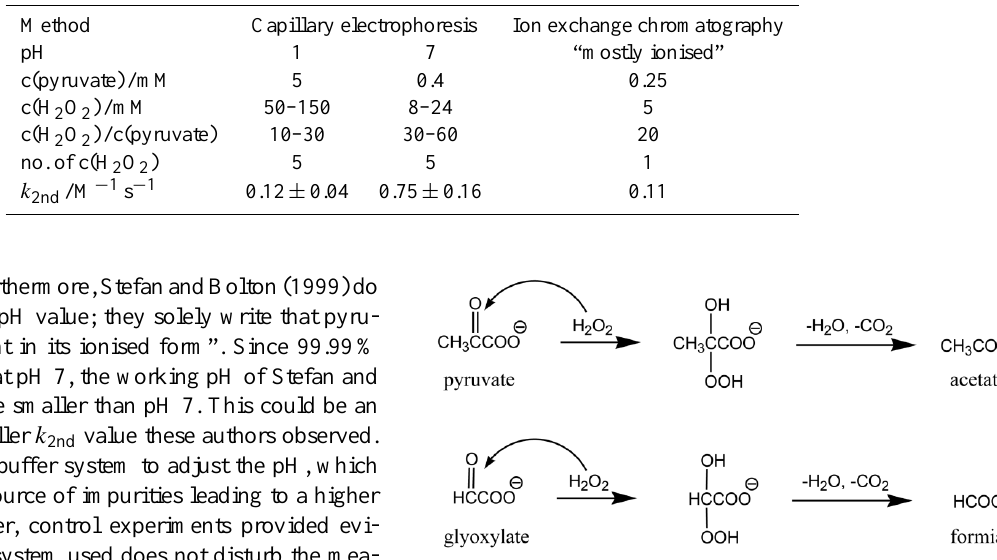
Scheme 3. Reaction mechanism of pyruvate and glyoxy- late+H 2 O 2